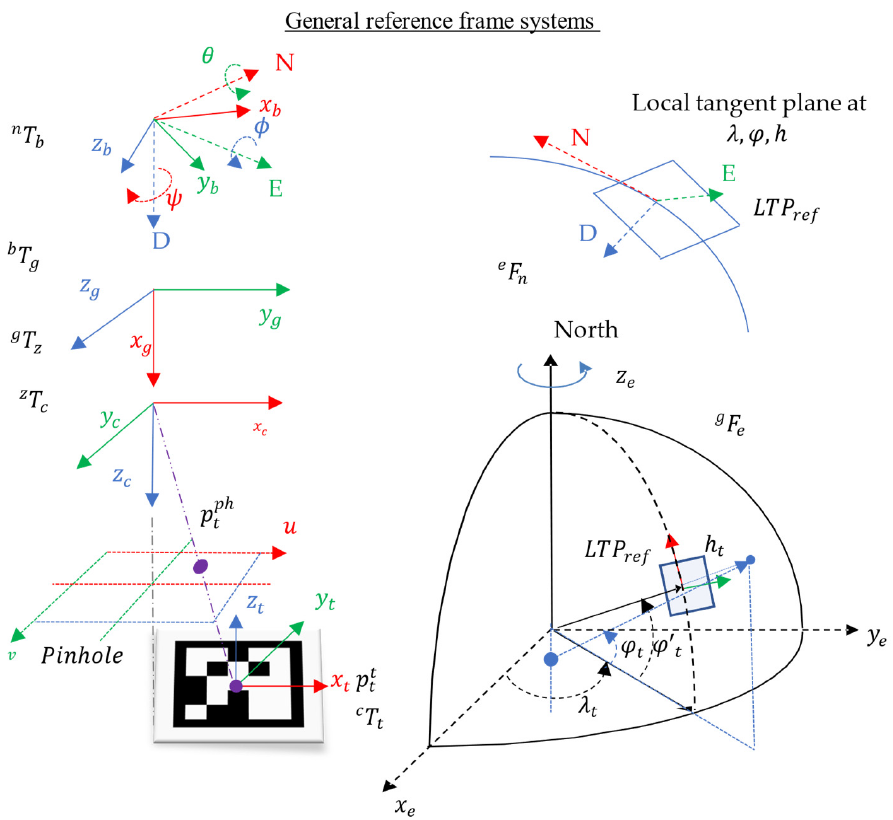
Figure 1. General reference frame systems. Reference frames bottom-left to up: helipad (target), pinhole camera model (image plane), camera, gimbal socket, body, NED. Reference frames right up to down: NED, ECEF, Global.